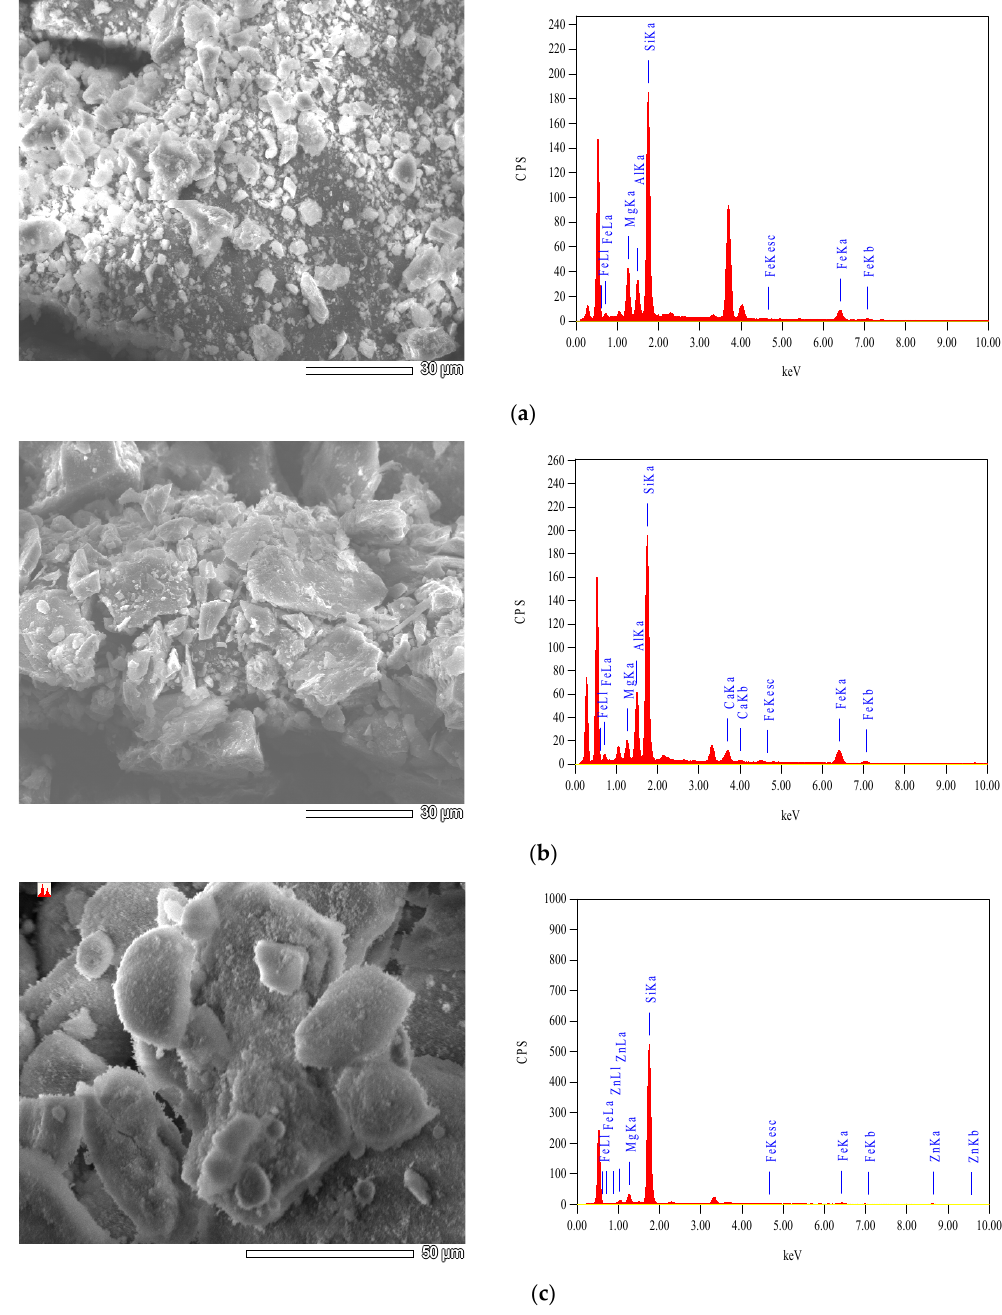
Figure 2. The EDS of the recycled concrete powder, recycled natural powder, and silica fume: ( a ) RCP; ( b ) AMF; ( c ) SF. Table 2. The chemical compositions of OPC, RCP, AMF, and SF.